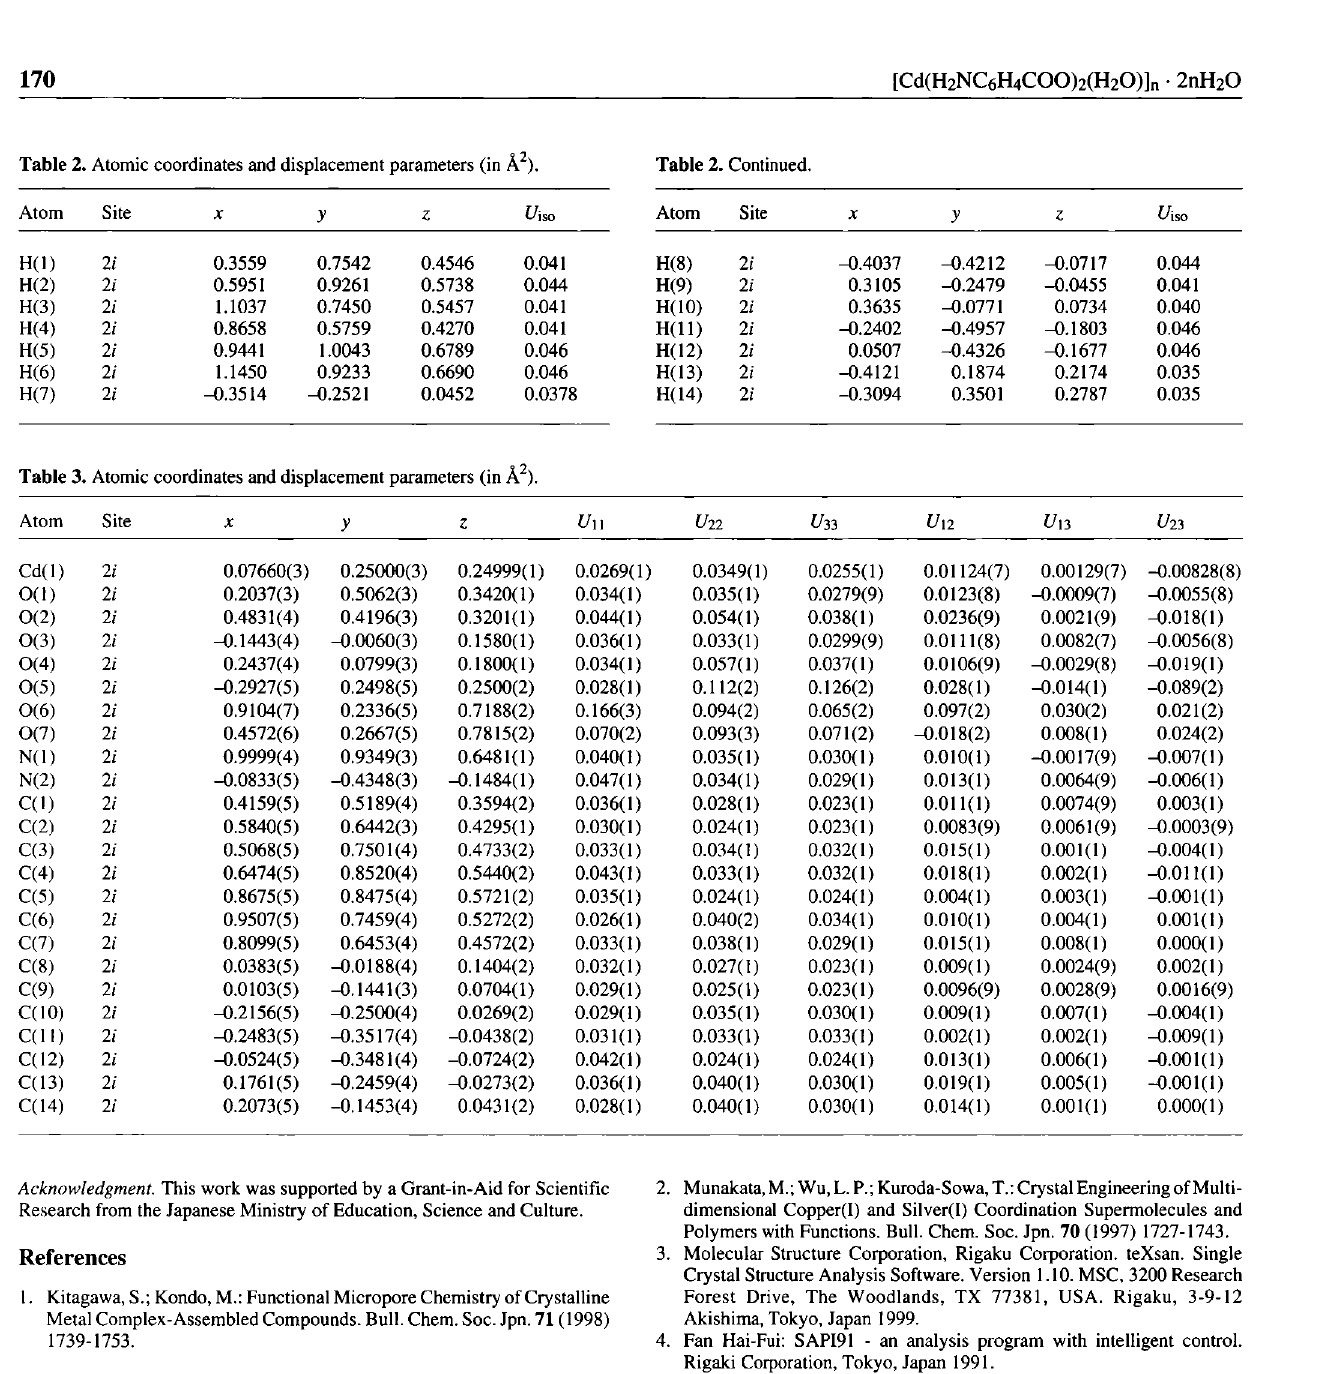
Table 2. Atomic coordinates and displacement parameters (in Ä 2 ).